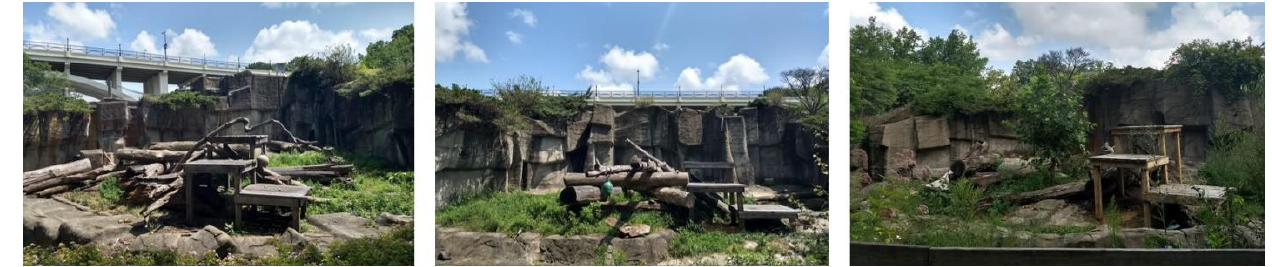
Tropical Bear Habitats, Left, Center, and Right